Question: Based on the figure, does the quantity rise or fall?
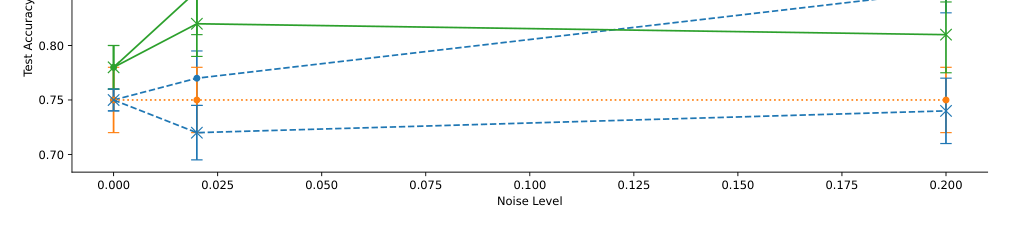
Answer: increasing